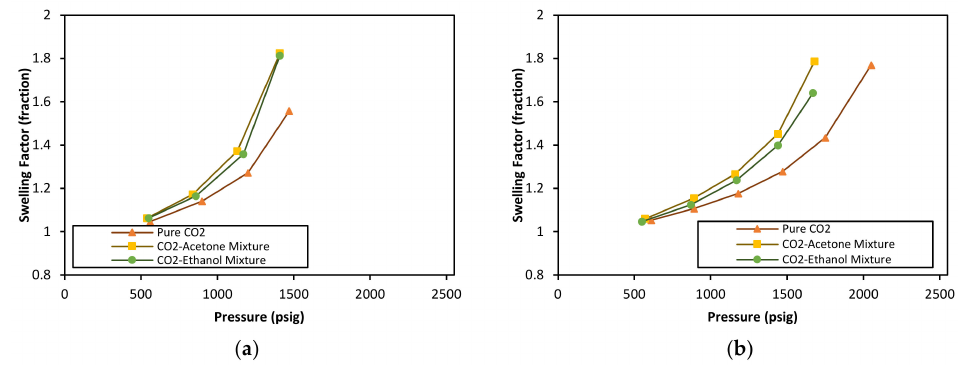
Figure 2. Swelling test results at ( a ) 131 ◦ F and ( b ) 158 ◦ F